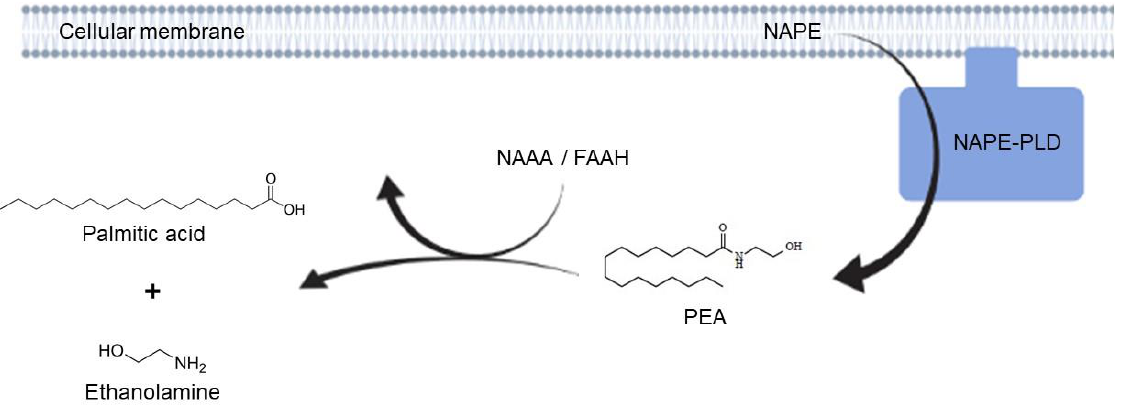
Figure 1. Schematic representation of PEA biosynthesis and catabolism. NAPE = N-acyl